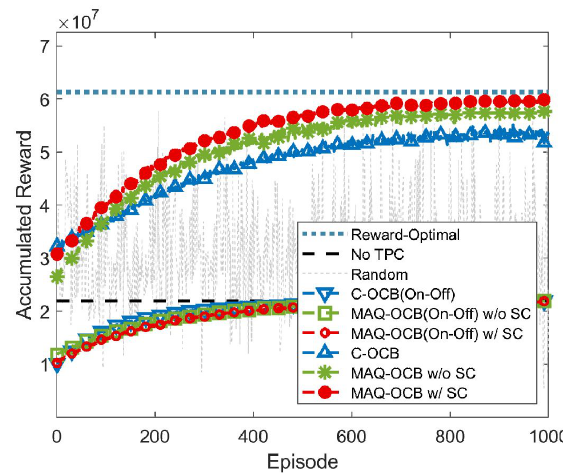
Figure 3. Reward vs. episode when | U | = 60, | M | = 3, and | N | =